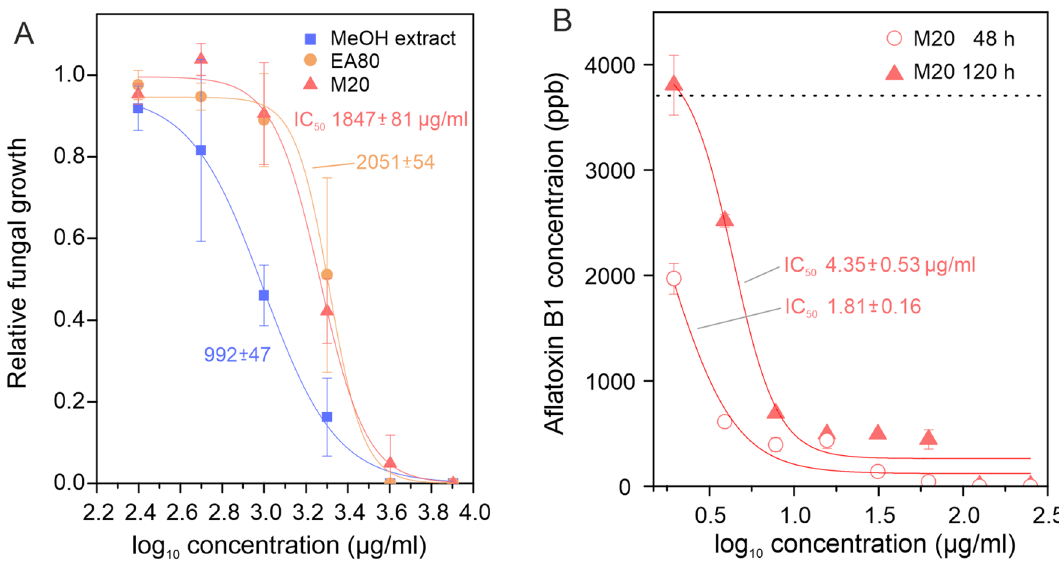
Figure 3. Antifungal and anti-aflatoxigenic activity of plant extracts. ( A ) Antifungal activities of crude methanol extract, and EA80 and M20 fractions of Z. bungeanum . Extract and fractions were used at 250, 500, 1000, 2000, 4000 and 8000 µg/mL concentrations. Relative A. flavus growth in liquid culture was estimated as optical density after 48 h culture. ( B ) Effects of the M20 fraction on AFB1 accumulation in A. flavus liquid culture medium after 48 or 120 h culture. M20 was used at 1.95, 3.9, 7.8, 15.7, 31.3, 62.5, 125 and 250 µg/ mL concentrations. Dashed line indicates AFB1 production level in the absence of M20. Error bars in both panels are SDs for the averages of three biological replicates. Data were fit to Eq. (3), and IC 50 ± SE values were calculated using Eq. (4). For all samples, ANOVA rejected the null hypothesis that all extract concentrations behaved the same ( p <